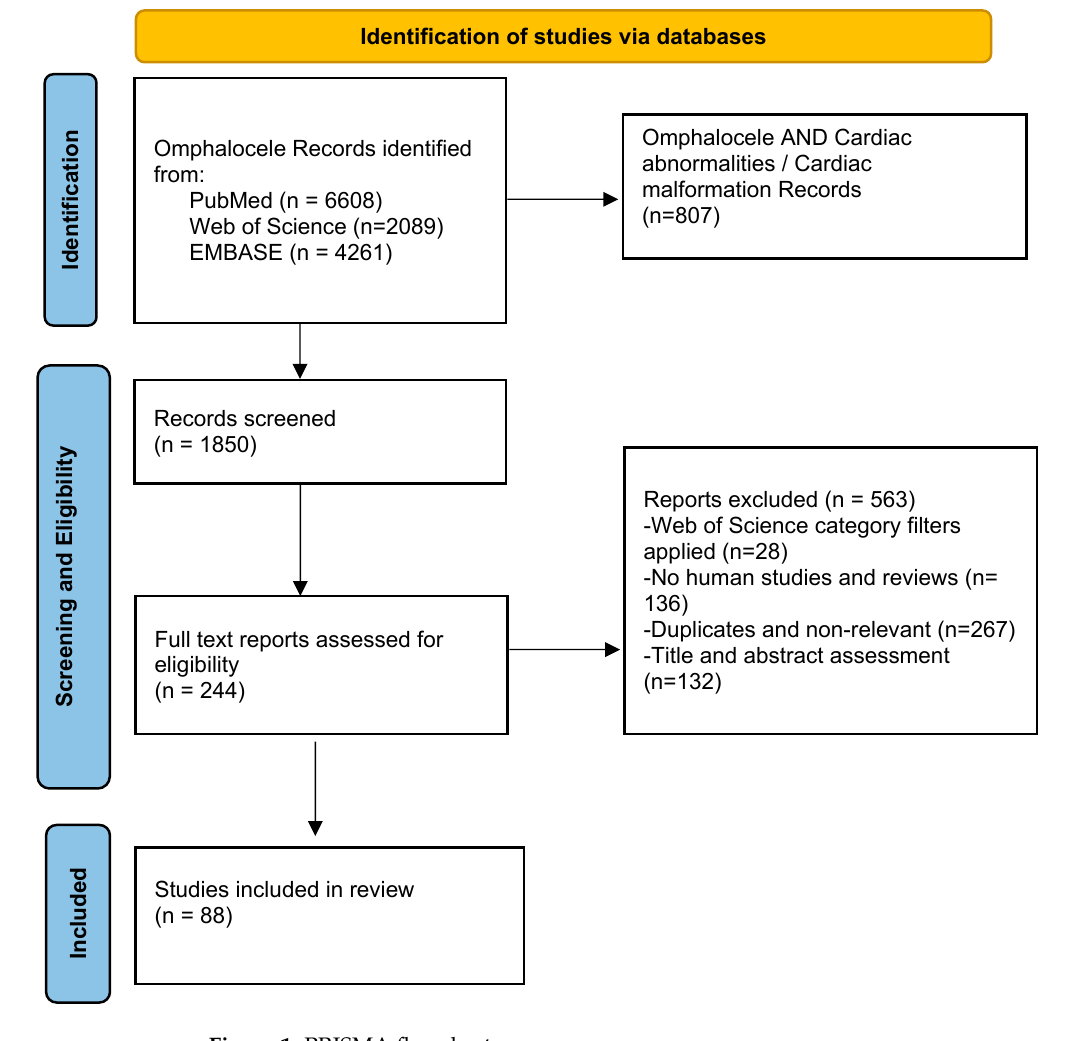
Figure 1. PRISMA